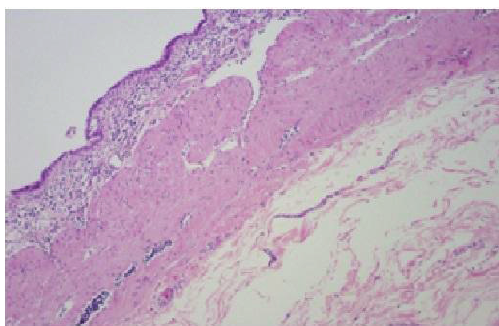
Figure 3: Photomicrograph: cyst wall was composed of mucosa, submucosa, and muscularis propria. The mucosa was predomi- nantly a gastric body type with patchy intervening areas of simple columnar epithelium containing apical mucus and cilia seen in embryonic intestinal